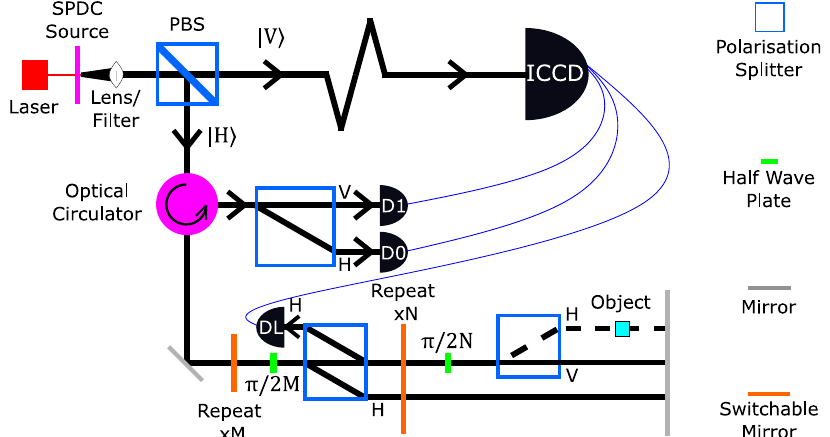
Fig. 2 Our counterfactual ghost imaging protocol. This is based on the combination of standard ghost imaging (Fig. 1) and a common-path interferometer version of Salih et al. ’ s counterfactual communication protocol 18 . We create a pair of position-and-momentum-entangled photons, one horizontally polarised and one vertically polarised, by passing a pulsed pump laser through a spontaneous parametric downconversion (SPDC) crystal, before collimating the beam, and fi ltering out the pump. The photon pair is split at a polarising beamsplitter (PBS), with the V -polarised photon going through a long optical delay to an Intensi fi ed Charge-Coupled Device (ICCD) camera, and the H - polarised photon going through a run of Salih et al. ’ s protocol, adapted so the object to be investigated is put in place of Bob ’ s blocker. The switchable mirrors allow the photon to cycle the correct number of times: the fi rst for M outer cycles; and the second for N inner cycles per outer cycle. The polarisation separators subtly divert horizontally polarised light, and directly transmit vertically polarised light. The half-wave plates are tuned to implement a ^ R y ð θ Þ polarisation-mode rotation with θ of π /2 M and π /2 N , respectively. The detector DL acts as our loss channels (which we postselect against). After M outer cycles, the switchable mirror sends the photon to the optical circulator, which sends it to the PBS. The path not being blocked by the object leads the photon to remain H -polarised, and so go to D 0, leading to a coincidence measurement between that and the ICCD camera; however, the path being blocked leads to the photon becoming V -polarised and so going to D 1, so coincidence measurement between that and the ICCD. The use of multi-mode interferometers and (position-momentum) correlations between the entangled photons enables multi-mode ghost imaging in this counterfactual set-up. Note, the polarisation separators ensure a common path length for both H- and V -polarised components, while generating beam separations of the several millimetres. An optimisation we mention in the discussion has photons going to DL can trigger a coincidence measurement with the ICCD, treated as if it was a detection at D 0, which does not affect the chance of photons interacting with the object (photons only go to DL if the object does not block the channel), and allows us to lower the number of outer cycles to the minimum required (2) with no increase in loss.